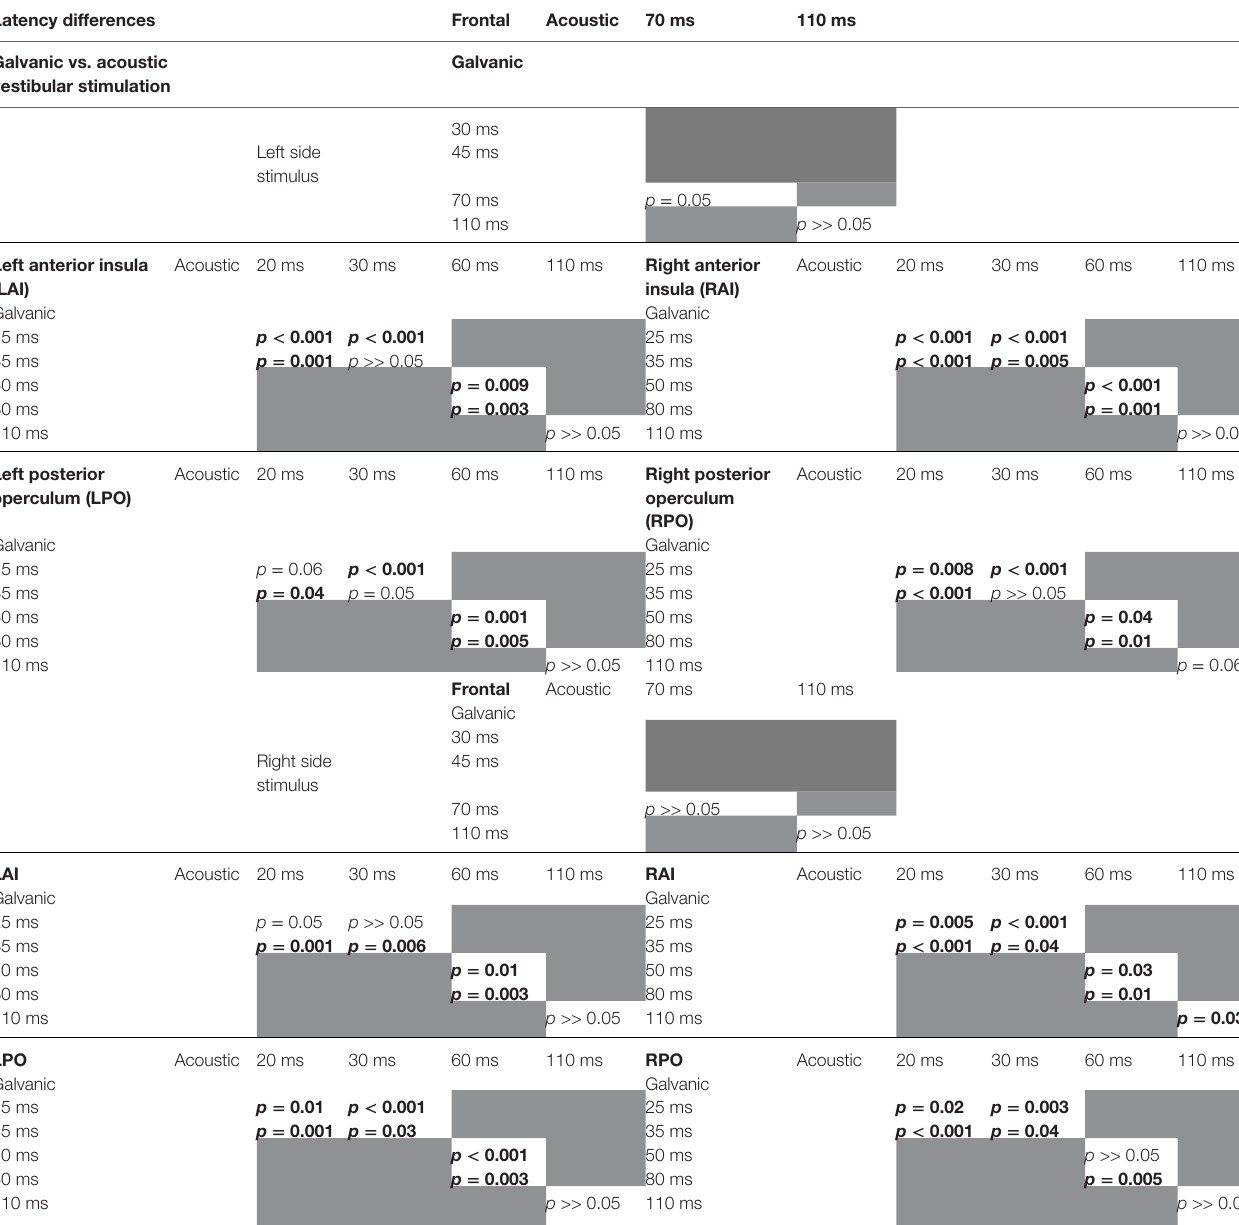
TaBle 3 | Comparison between potentials evoked by galvanic stimulation and acoustic stimulation from the previous study (8). latency differences Frontal galvanic vs. acoustic vestibular